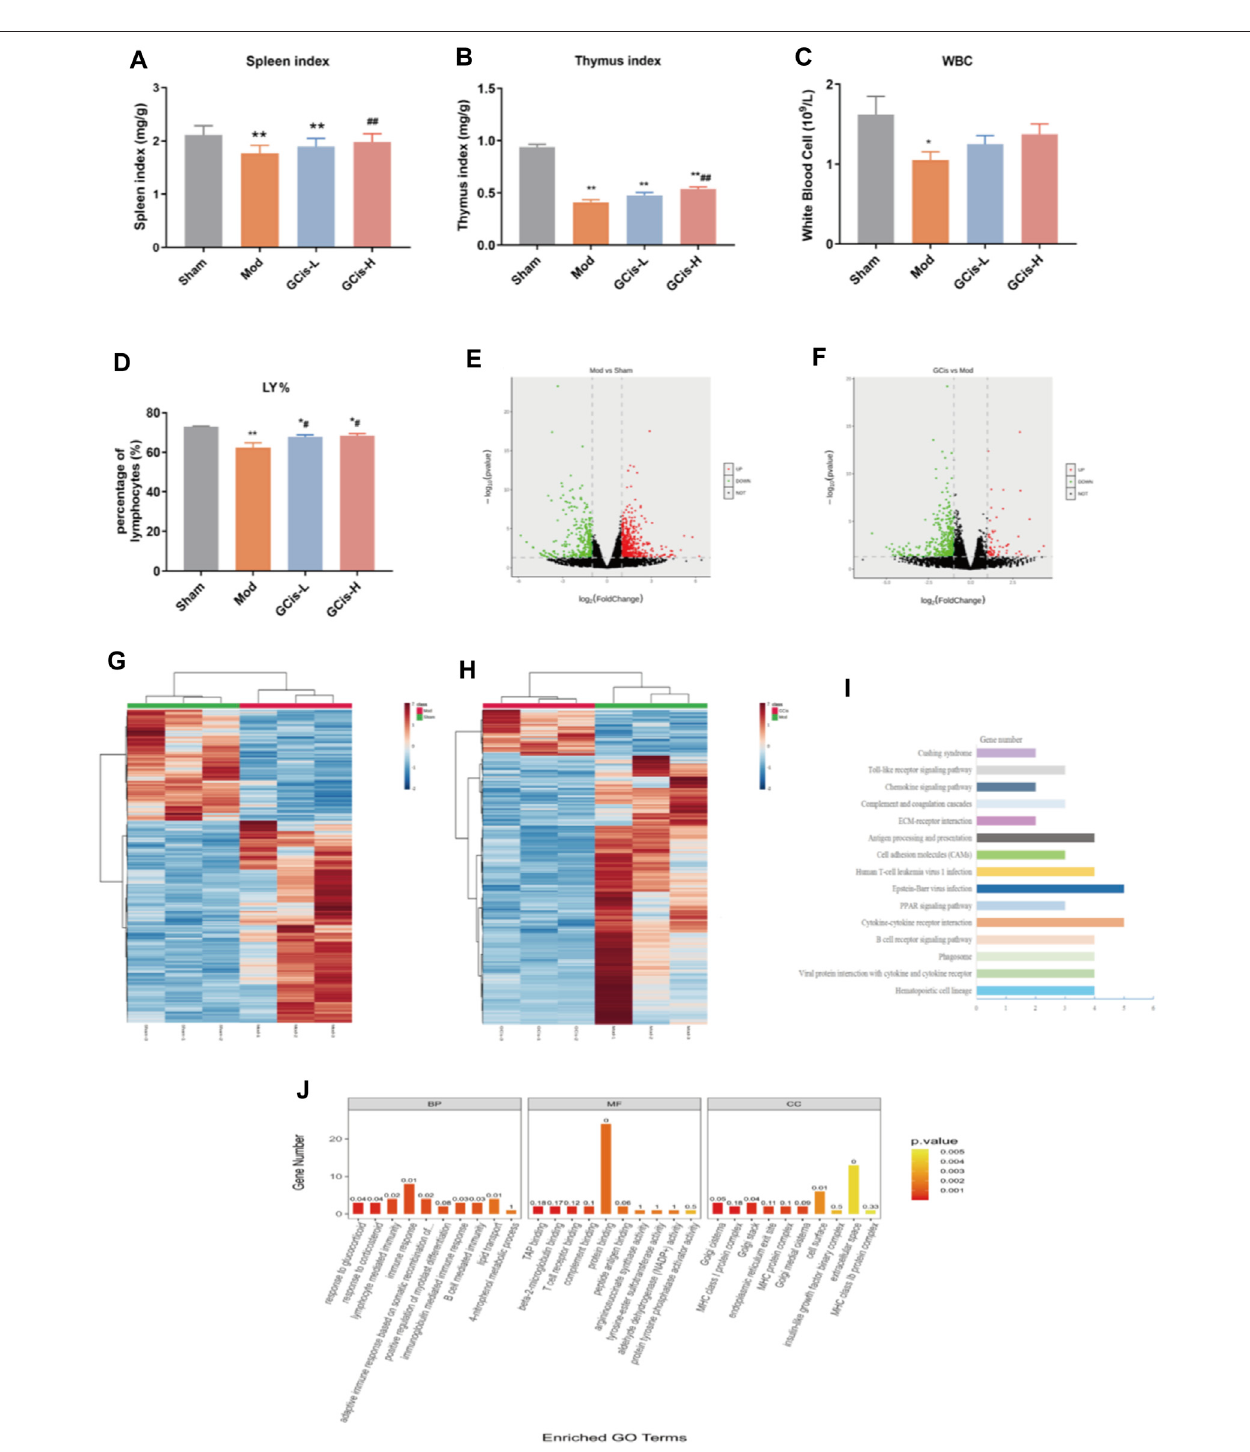
FIGURE3| GCisformulapreconditioningenhancedperipheralimmunityinthelunginfectionmice. (A) Spleenindex, (B) thymusindex, (C) whitebloodcell,and (D) LY%. The upregulated (red) or downregulated (blue) genes (E) . (G) Sham group vs . model group (F) . (H) GCis group vs . model group. Bioinformatics analysis (GO and KEGG annotation) of 61 DEGs. (I) KEGG analysis of GCis 61 DEGs. (J) GO analysis of GCis 61 DEGs (data are shown as mean ± SEM. * p < 0.05 and ** p < 0.01 compared with the sham group; # p < 0.05 and ## p < 0.01 compared with the model group).